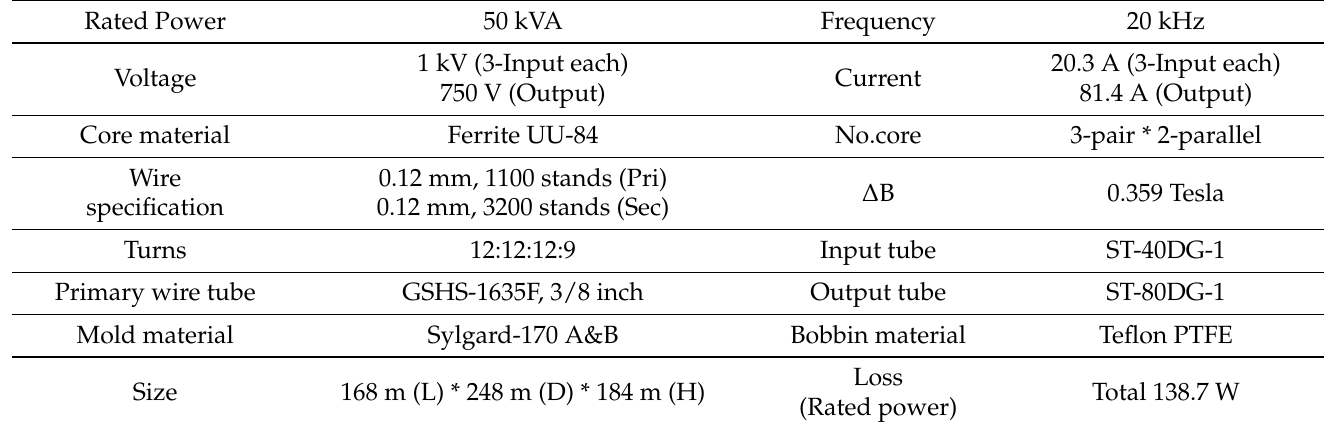
Table 2. Design specifications of the high-frequency isolation transformer.